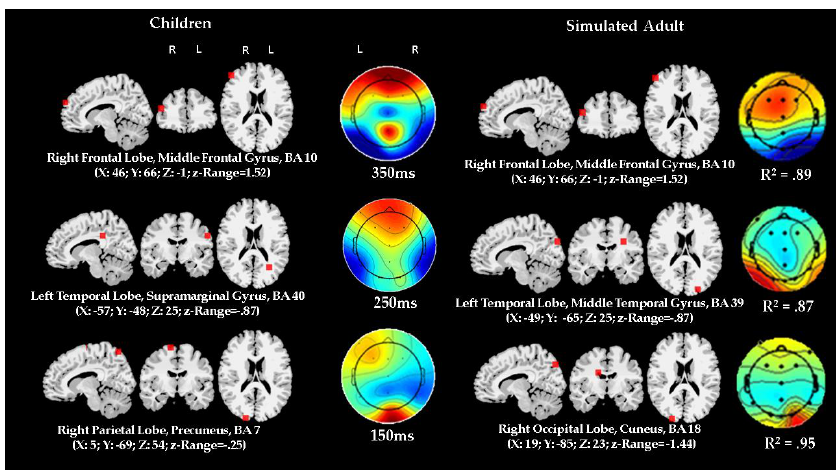
Figure 7. Comparison between dipole source analysis and topographical mappings of actual preschool children ERP data and simulated ERP data by using an ACT–R modeling architecture in the target condition. Timings are set by the ACT–R model module production schedule simulation (given in Figure 3). Coefficient of determinations show fit results for actual and simulated topographic maps comparisons. “R” represents right, and “L” represents left (Please note that lateral side of brain is showed opposite to perspective of the observer in MRI scans). Z-range represents range of normalized Talairach coordinates and is a measure of margin of error expressed as z score; comparisons between the z-ranges in actual and simulated data showed no significant differences.